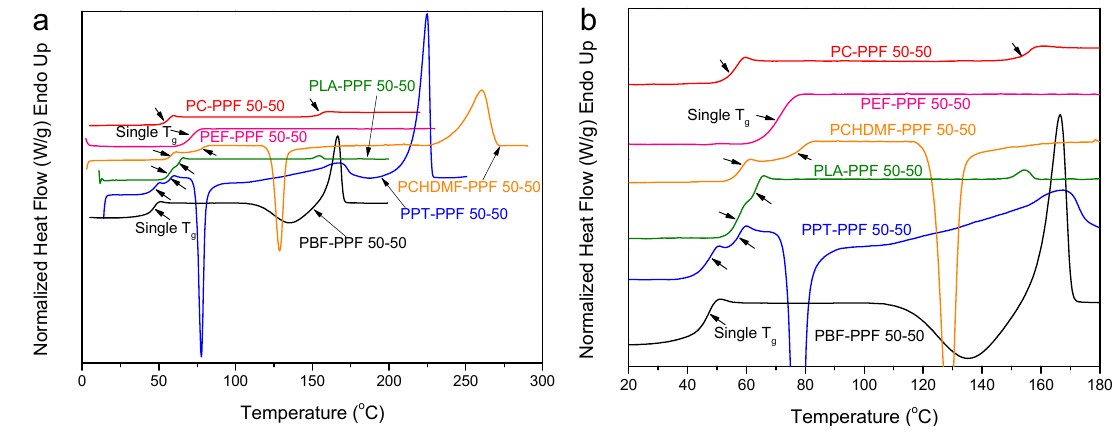
Figure 12. ( a ) DSC heating thermograms, ( b ) details of DSC thermograms in the T g region, for melt- quenched PPF blend samples with various polymers and 50-50 composition.